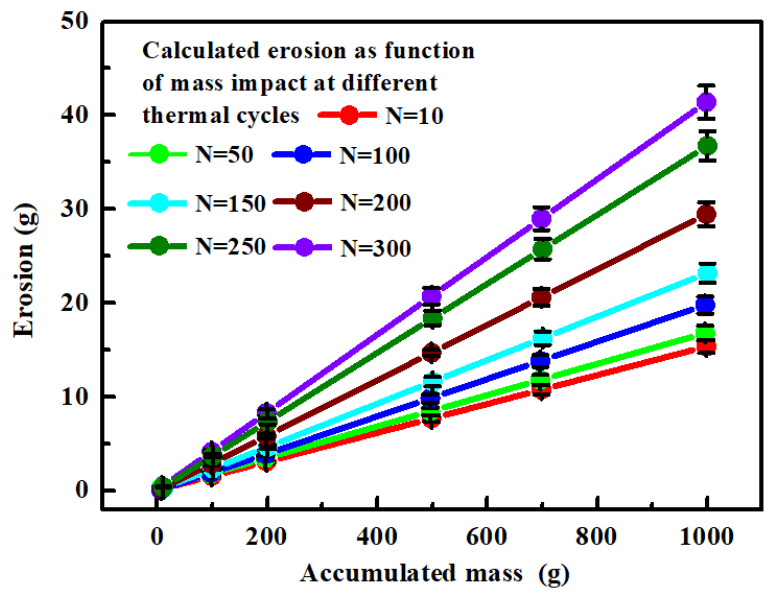
Figure 15. The calculated erosion versus accumulated mass at selected thermal cycles. It is evident that a linear relationship is obtained for erosion versus accumulated Table 8. Parameters used to calculate erosion rates at different impact angles. mass, in which the erosion rate (slope of curves) is constant. For erosion calculated at different stages of thermal cycles, it is suggested that the growth of sintering cracks plays a significant role in lowering the magnitude of kinetic energies, as shown in Figure 12, which results in higher erosion estimated at later stages of thermal cycles. The effect of impact angles on erosion is discussed based on the parameters used and tabulated in Table 8. The erosion rates are calculated versus impact angles ranging from 5 ◦ to 90 ◦ at various stages of thermal cycles, as shown in Figure 16.